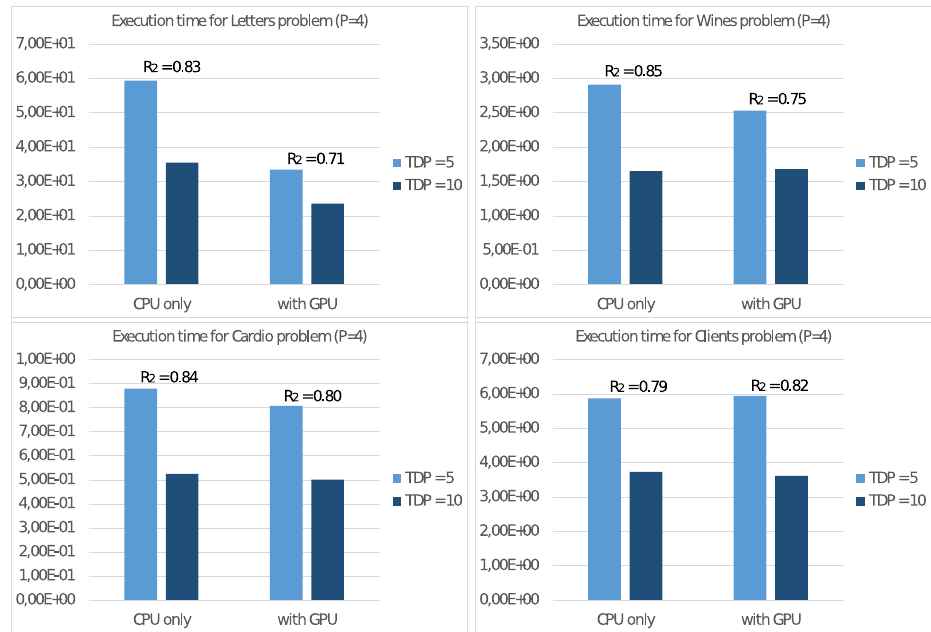
Figure 7. Execution time (in seconds) and energy consumption ratio R 2 of the NVIDIA Jetson Nano with two different